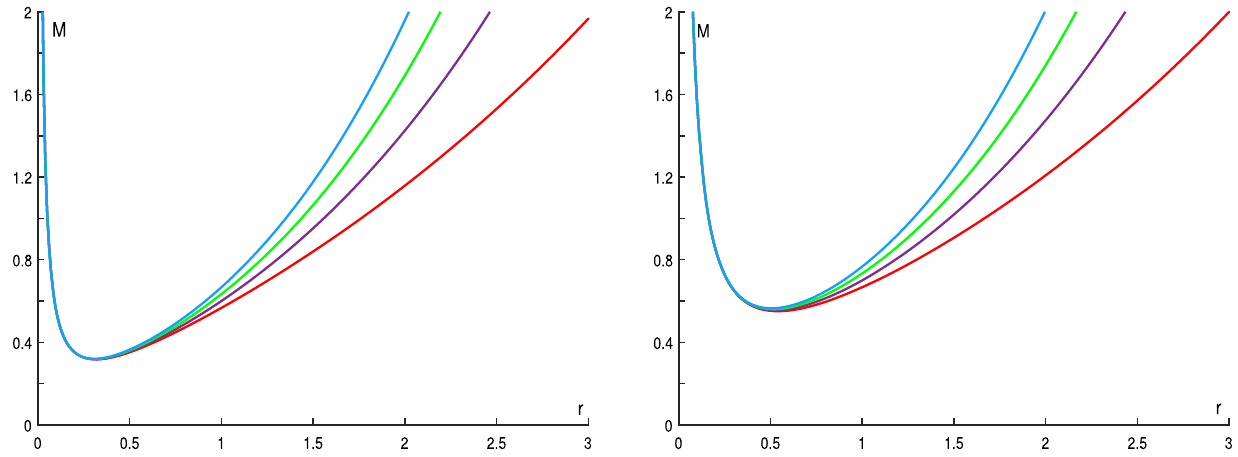
Fig. 5 The behavior of mass versus radius for the AdS 4D EGB black hole. Left plot has been depicted with α = 0 . 1 and right one with α = 0 . 3 while (cid:5) = 0 . 7 , 0 . 5 , 0 . 30 . 1 from up to down. These plots illustrate that (cid:5) changing affects the asymptotic behavior